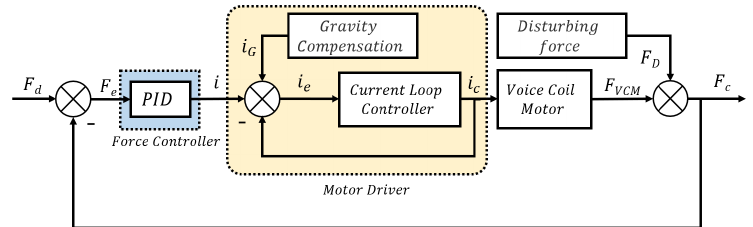
Figure 7. Experimental hardware.